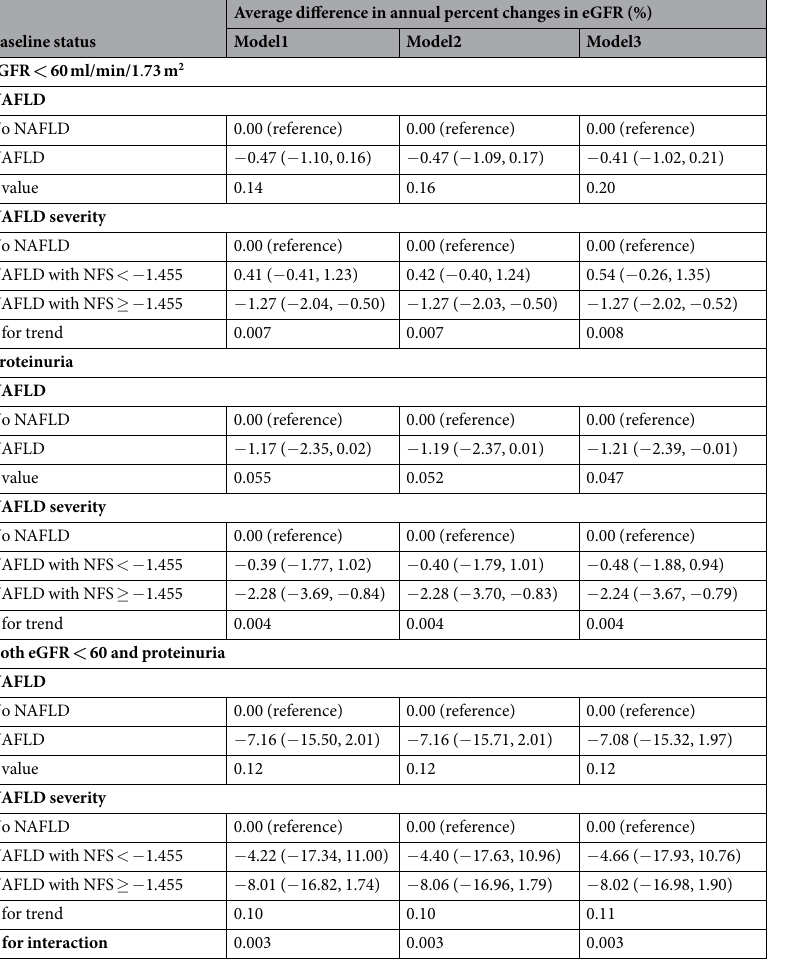
Table 3. Average difference in annual percent change in estimated glomerular filtration rate (eGFR) according to the presence and severity of nonalcoholic fatty liver disease (NAFLD) and CKD criteria (n = 1,525). eGFR, estimated glomerular filtration rate; NAFLD, non-alcoholic fatty liver disease; NFS, NAFLD fibrosis score. Model 1: Adjusted for age, sex and year of visit Model 2: Further adjusted for baseline smoking status (never, former, current, and missing), alcohol intake (none and moderate), and body mass index. Model 3: Further adjusted for hypertension, diabetes, hyperlipidemia, systolic blood pressure, hemoglobin A1c, LDL cholesterol, and triglycerides (log e -transformed). For the NFS analyses, the models were not adjusted for age, body mass index, and diabetes as these factors are included in the calculation of the